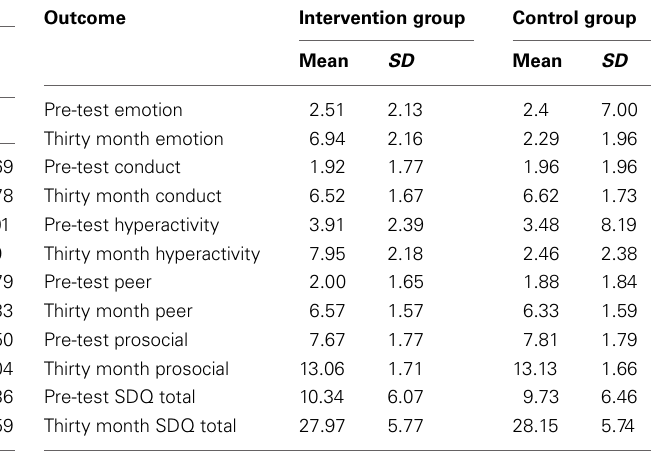
Table 4 . As part of the regression analysis, regression coefficients,